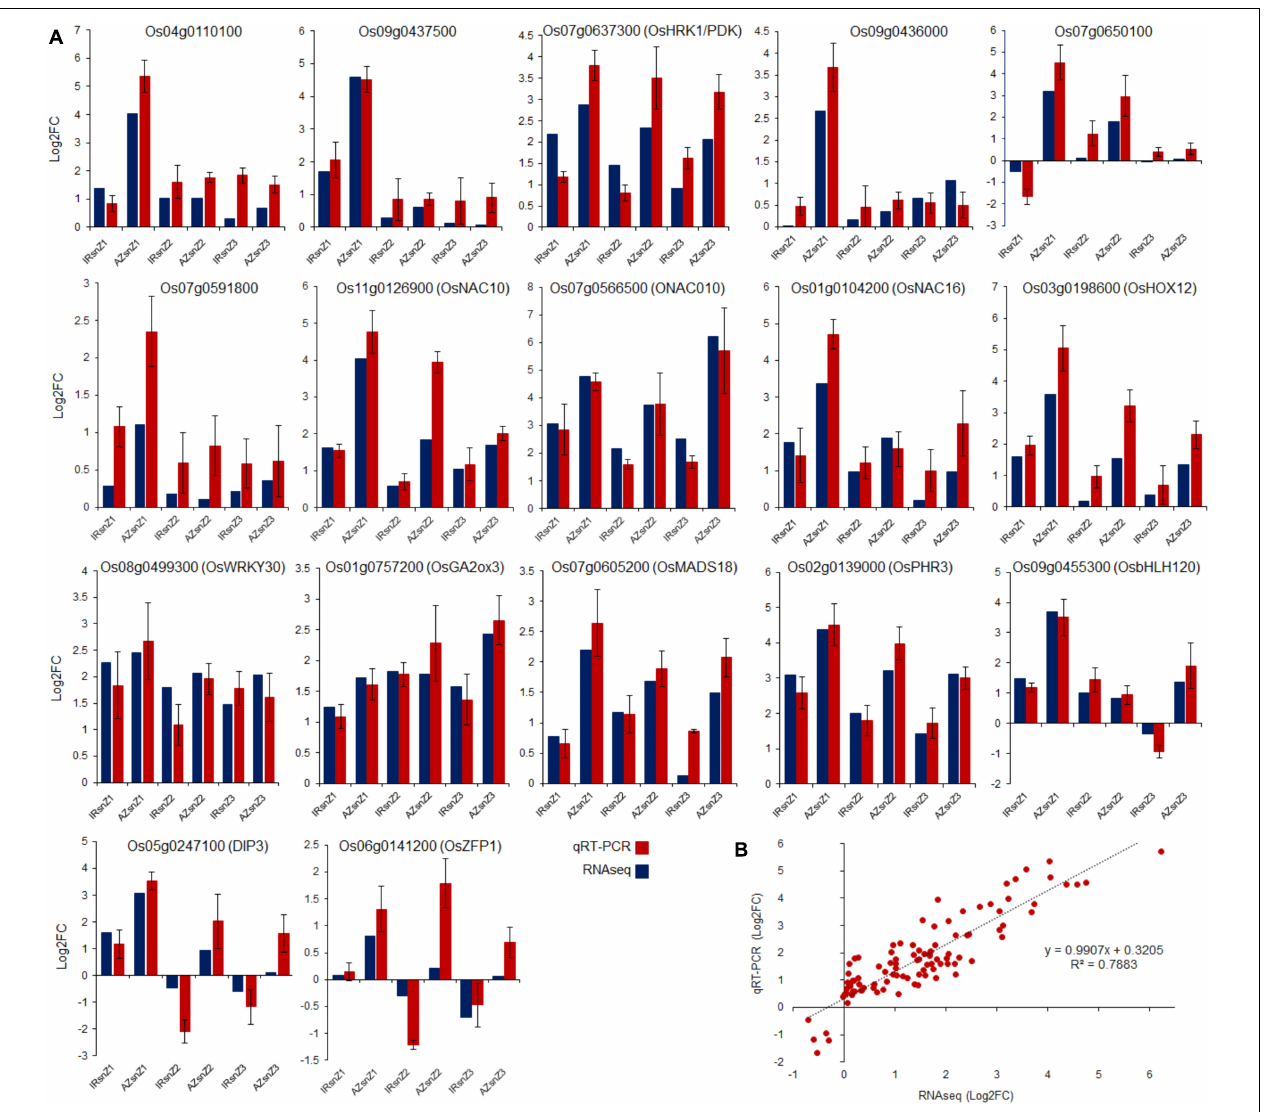
FIGURE 10 | Validation by qRT-PCR. (A) Validations of selected genes using qRT-PCR in all three root zones of both genotypes, Azucena and IR64, in response to water stress. Data points are represented as log2fold change values. (B) Linear regression analysis between qRT-PCR and RNA-seq results ( R 2 = 0.7883) for 17 genes. X -axis numbers represent the log2fold-change values of mRNA-seq results. Y -axis numbers represent the log2fold-change values of qRT-PCR